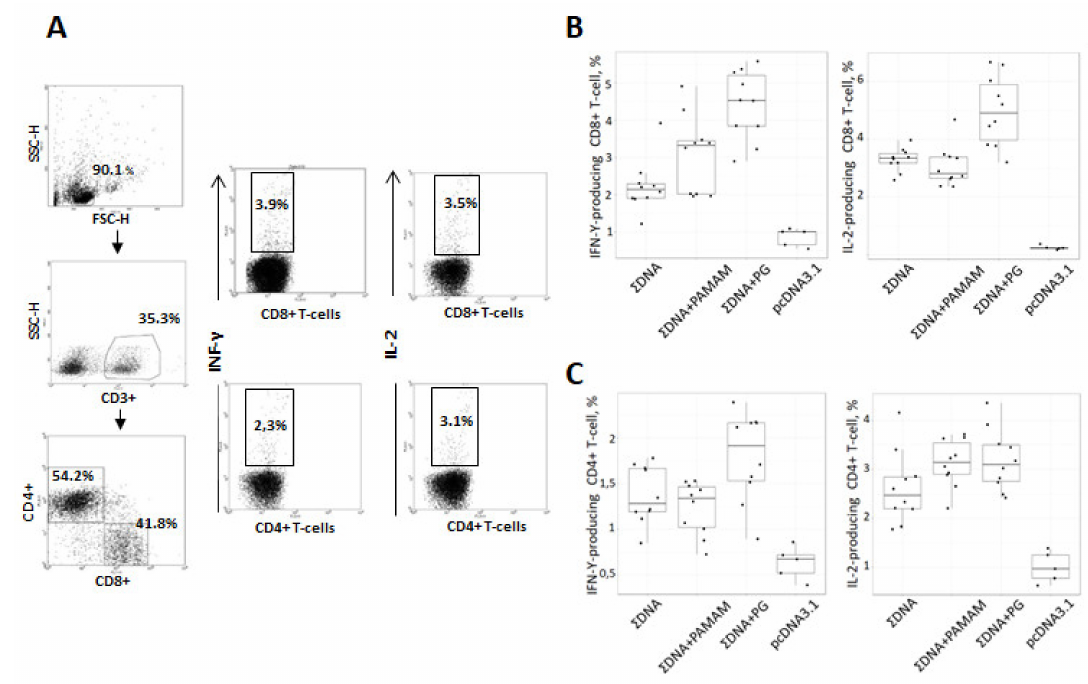
Figure 7. Intracellular cytokine staining with flow cytometry analysis of INF- γ and IL-2 expressing CD8 +/ CD4 + splenic T cells stimulated with pool of synthetic peptides, corresponding to CTL- and Th-epitopes of Ebola virus proteins. Mice were immunized with naked plasmids or complex plasmids with cationic polymers three times with two weeks interval. After two weeks after last immunization splenocytes were collected and ICS were performed. ( A ) Gating strategy for intracellular cytokine staining. The gating strategy includes selection of living cells and separation of CD8 + and CD4 + T cells within CD3 + splenocyte populations. Respectively gated T-cell populations were then analyzed for expression of INF- γ or IL-2. ( B , C ) Diagrams showing the number of Ebola-specific INF- γ and IL-2 expressing CD8 + T-cell ( B ) and CD4 + T-cell ( C ) responses after in vitro stimulation with a mix of specific (cid:80) peptides as described in Materials and methods. DNA—mice immunized with a combination of DNA (cid:80) plasmids pEV.CTL and pEV.Th; DNA + PG—mice immunized with a combination of complexes of the (cid:80) conjugate polyglucin:spermidine with DNA plasmids pEV.CTL and pEV.Th; DNA + PAMAM—mice immunized with a combination of complexes PAMAM 4G with DNA plasmids pEV.CTL and pEV.Th; pcDNA3.1—mice immunized with vector plasmid. Statistical analysis was performed with pairwise comparison using either two-sided Mann-Whitney test implemented in R statistical